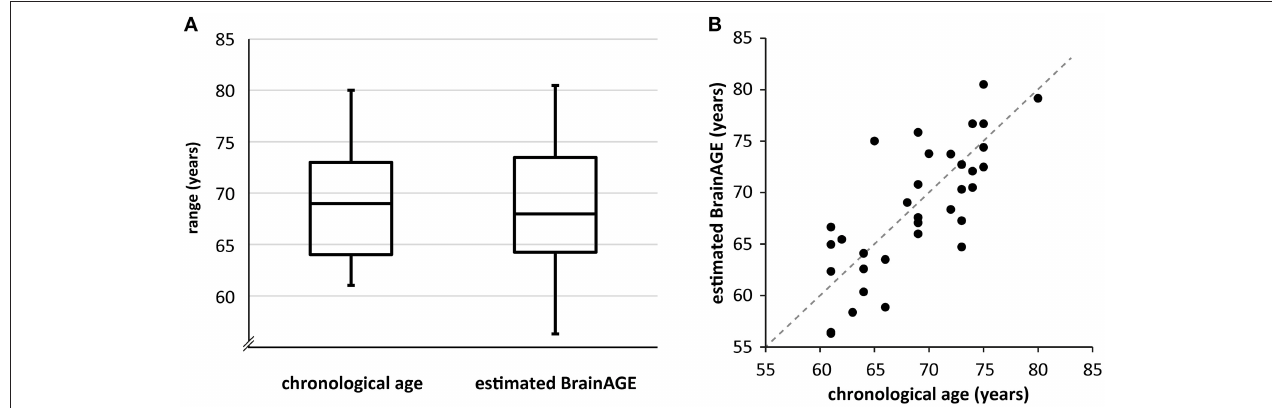
FIGURE 2 | (A) Boxplot of CA and estimated BrainAGE across the sample. The BrainAGE score was added to CA for immediate comparability. The line within the boxes represents the median, the outer lines of the boxes depict the first and the third quartile, respectively. The error bars reach from the first and third quartile to the respective extrema. Note that estimated BrainAGE shows higher variability than CA as well as a trend toward lower values. (B) Scatterplot of CA and estimated BrainAGE. The angle bisector represents the line where CA equals estimated BrainAGE. Please note that the data point that is situated directly on the angle bisector belongs to a participant with a positive BrainAGE of